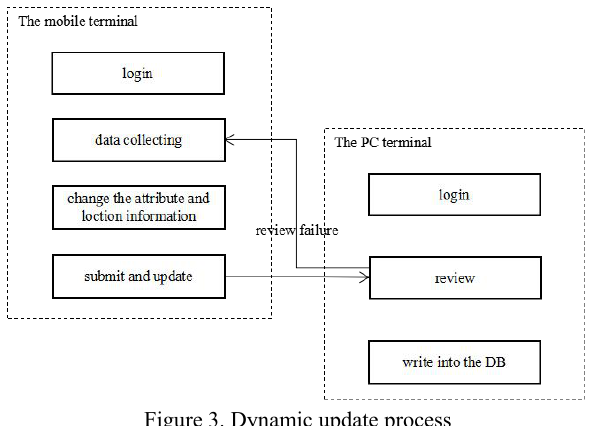
Figure 3. Dynamic update process